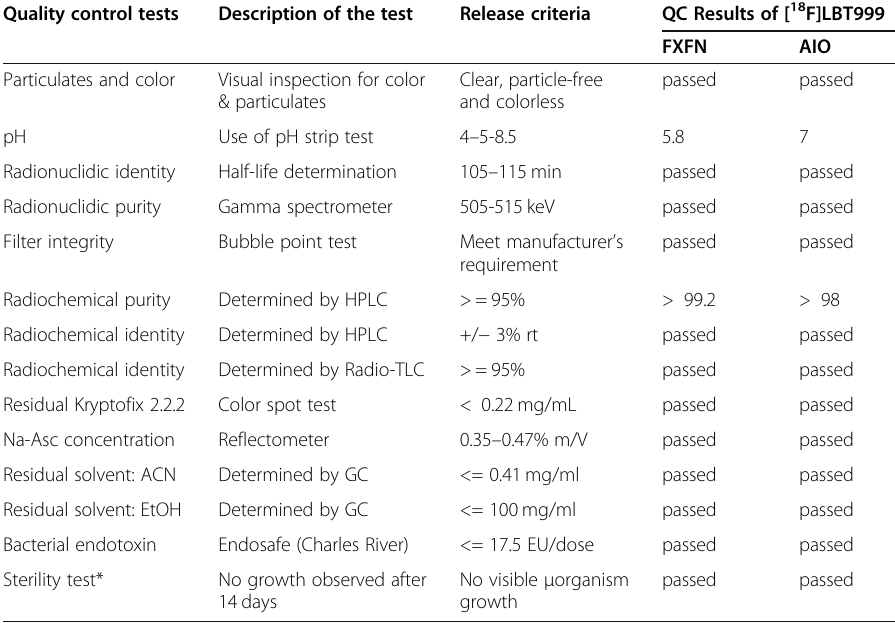
Table 3 Description and synthetic results of Quality control tests of [ 18 F]LBT999 for human injection after radiosynthesis on TRACERlab FXFN and AIO modules Quality control